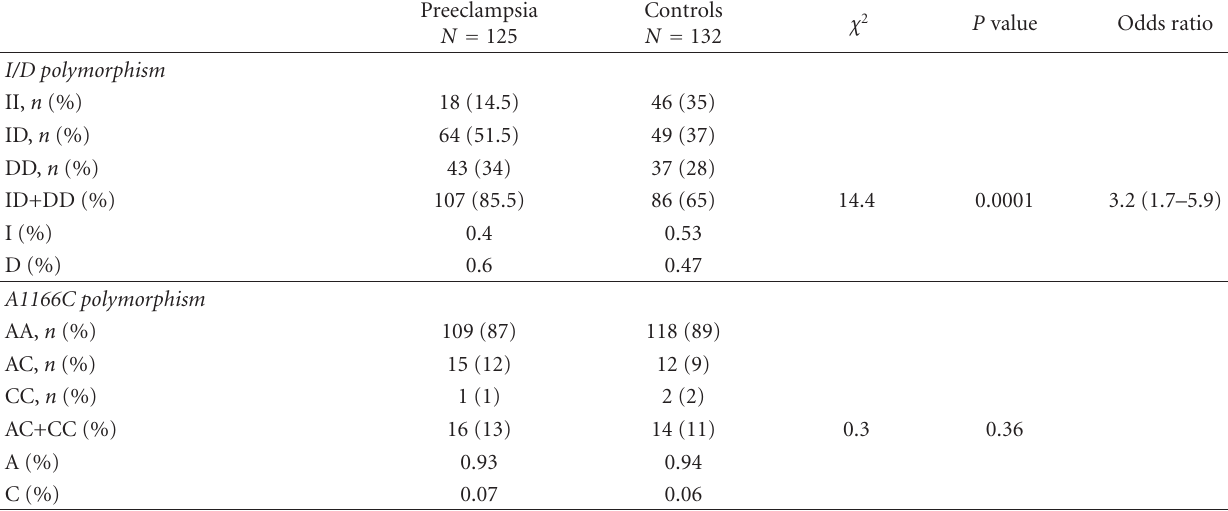
Table 2: Genotype and allele frequencies of I/D polymorphism of the ACE gene and A1166C polymorphism of the angiotensin II type-1 receptor in preeclamptic patients and